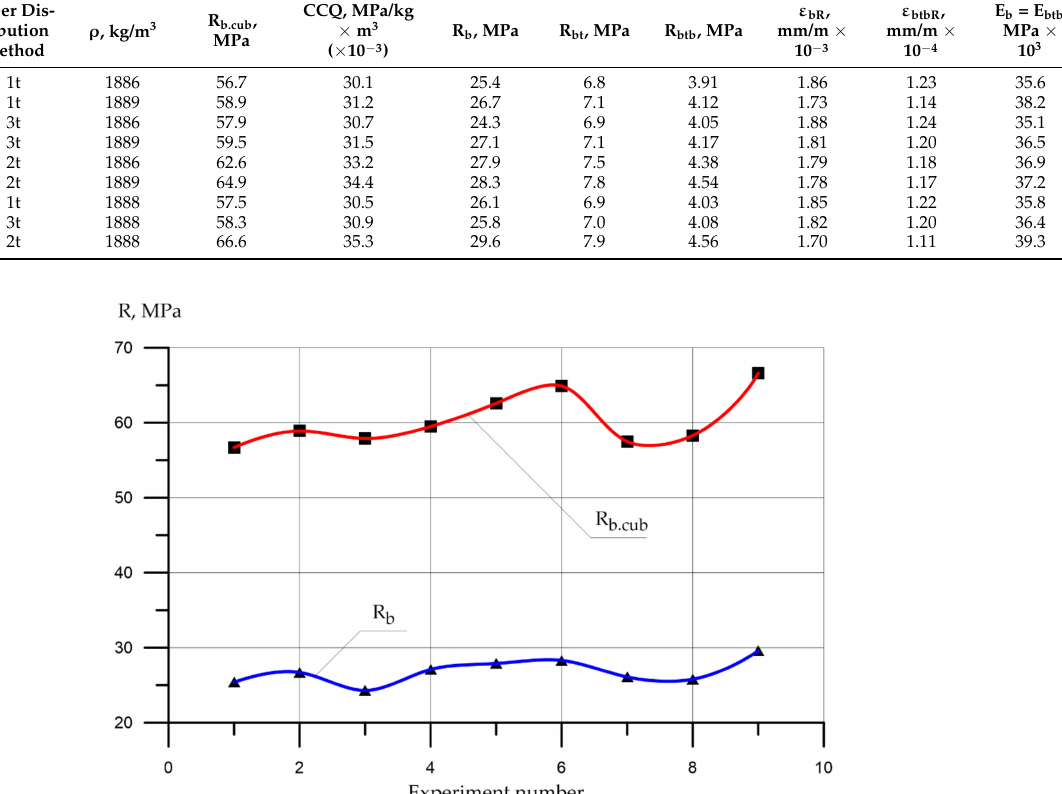
Table 11. Results of experimental studies on the influence of the volumetric content of fiber-reinforced concrete and the method of its distribution in the preparation of a fiber–concrete mixture on the physical–mechanical and deformative characteristics of LFRC on a combined aggregate.